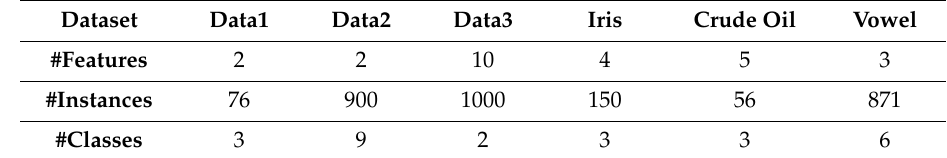
Table 1. Dataset Description.